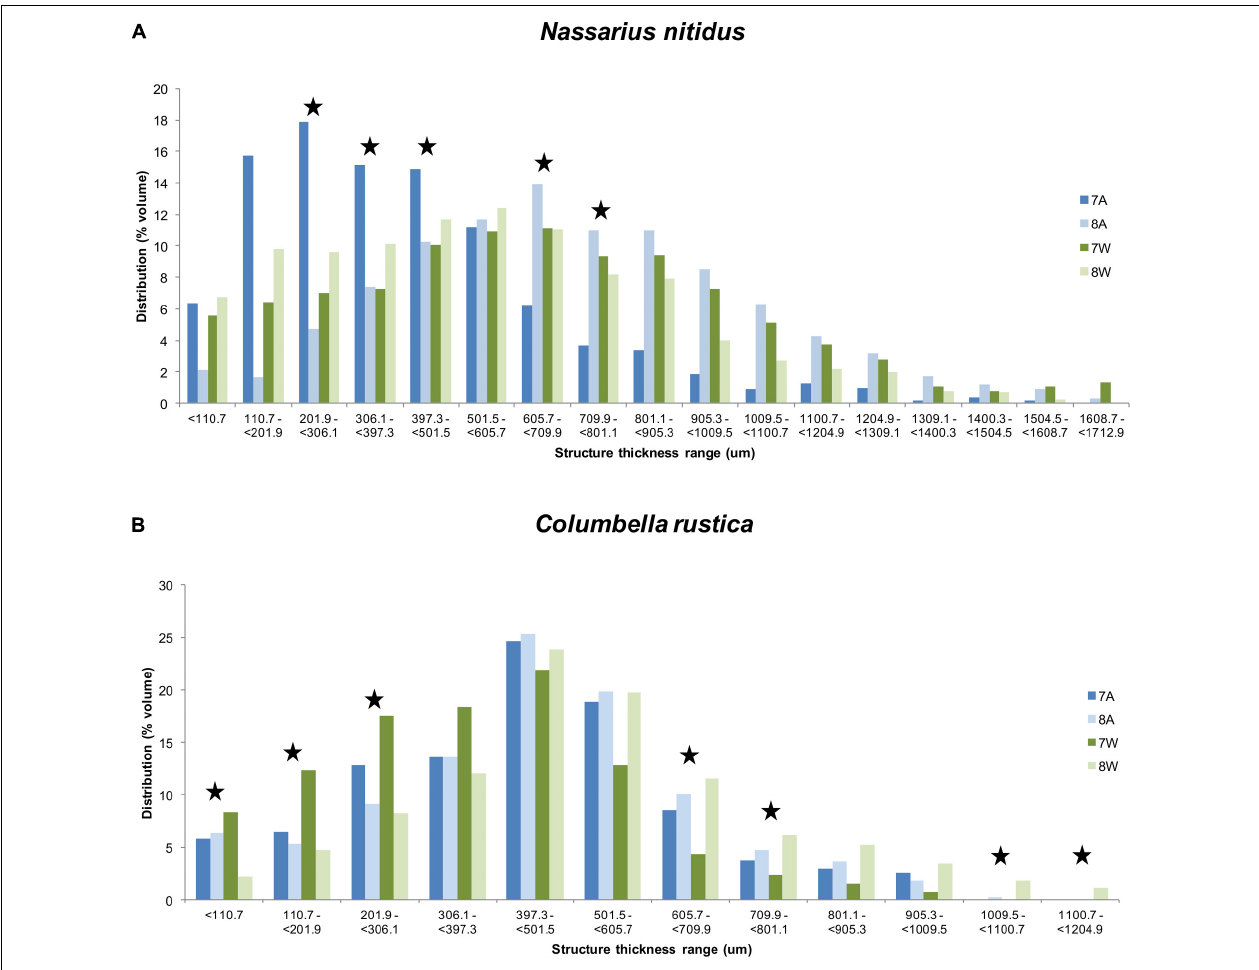
FIGURE 5 | Distribution (% average shell volume) of structure thickness classes (about 100 um per class) for Nassarius nitidus (A) and Columbella rustica (B) for the four experimental treatments as coded in the text (8A: 20 ◦ C and pH = 8; 7A: 20 ◦ C and pH = 7.7; 8W: 23 ◦ C and pH = 8; 7W: 23 ◦ C and pH = 7.7). Stars indicate thickness ranges with statistically significant differences ( p <